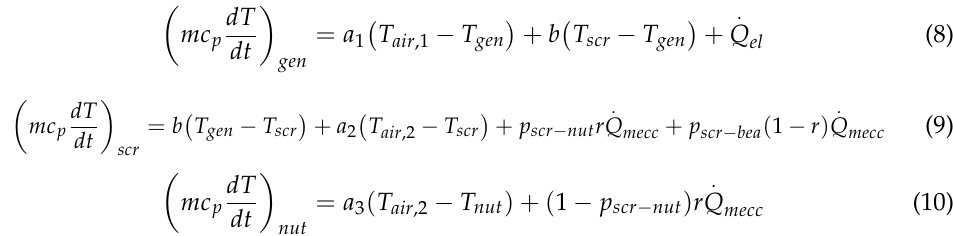
Figure 9. Instantaneous mechanical power losses in a single WEC operating cycle.